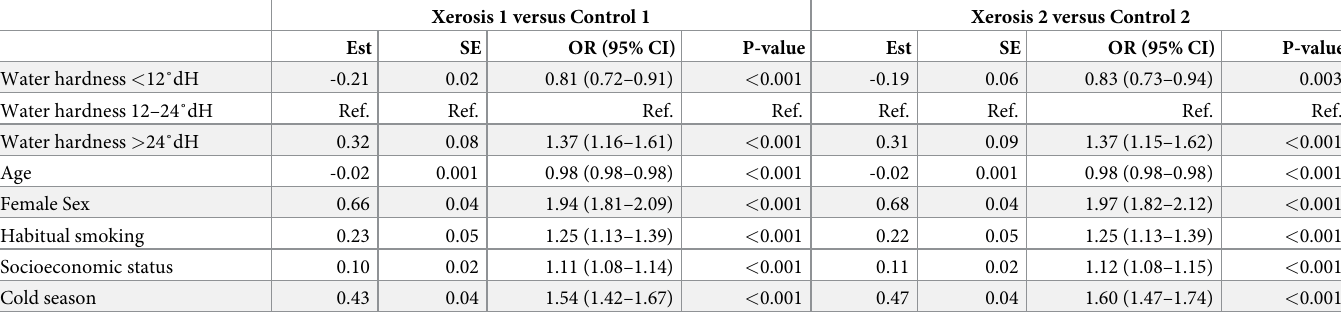
Table 2. Unadjusted nominal regression model with xerosis as outcome.